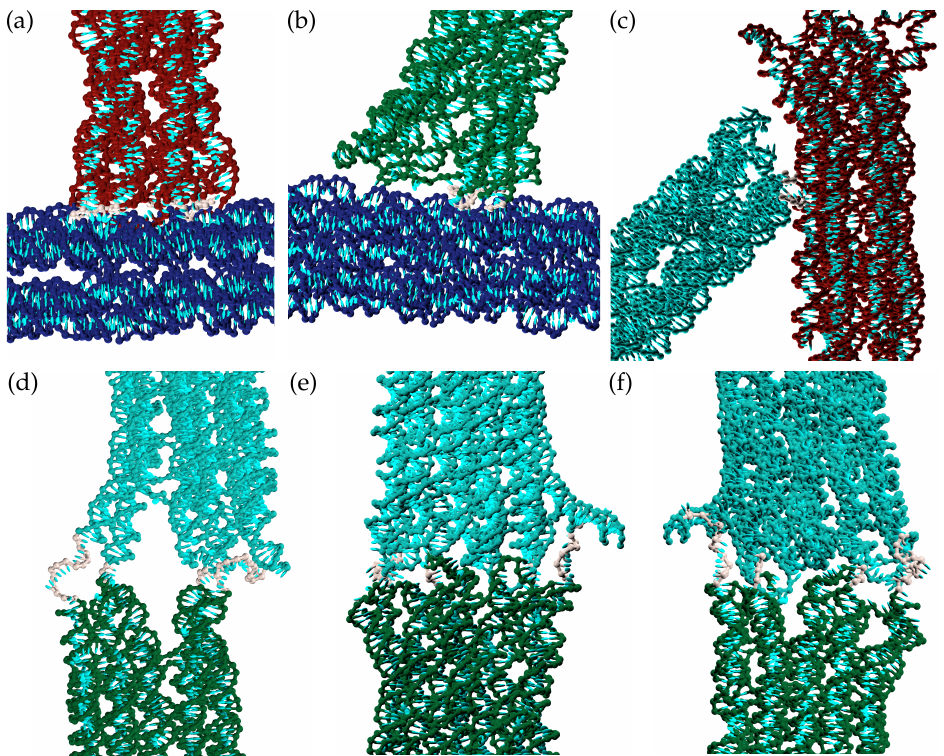
Figure 4. Close-ups of each joint for the configurations illustrated in Figure 3. Specifically, these are for ( a ) Joint 1 ( b ) Joint 2 ( c ) Joint 3 ( d ) Joint 4 (part 1) ( e ) Joint 4 (part 2, view from outside) ( f ) Joint 4 (part 2, view from inside). (The outside and inside of joint 4 are defined relative to the quadrilateral formed by the four blocks.) Single-stranded sections of the scaffold that link the blocks are coloured grey. ( d – f ) clearly show the difference in steric repulsion between the helices near the joint for open and closed configurations of joint